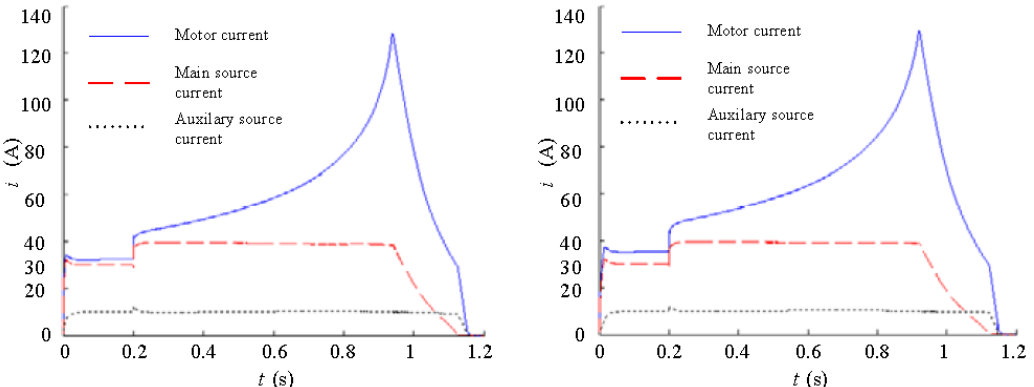
Figure 9. (a) The step response for the nominal model; (b) The step response for the perturbation model.